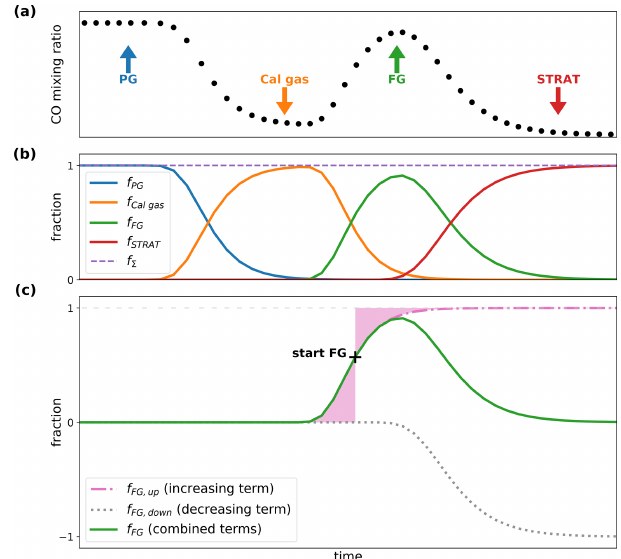
Figure 2. Idealized time series at the start of a GUF AirCore mea- surement with a Picarro CRDS. (a) CO mixing ratio time series. (b) Gas fraction time series of push gas (PG), calibration gas (Cal gas), fill gas (FG) and stratospheric sample (STRAT) correspond- ing to (a) . f (cid:54) is the sum of all fractions and always 1. (c) Example time series of increasing and decreasing term for the FG fraction. At the starting point “start FG”, the two areas of the increasing term indicated in pink are of equal size.